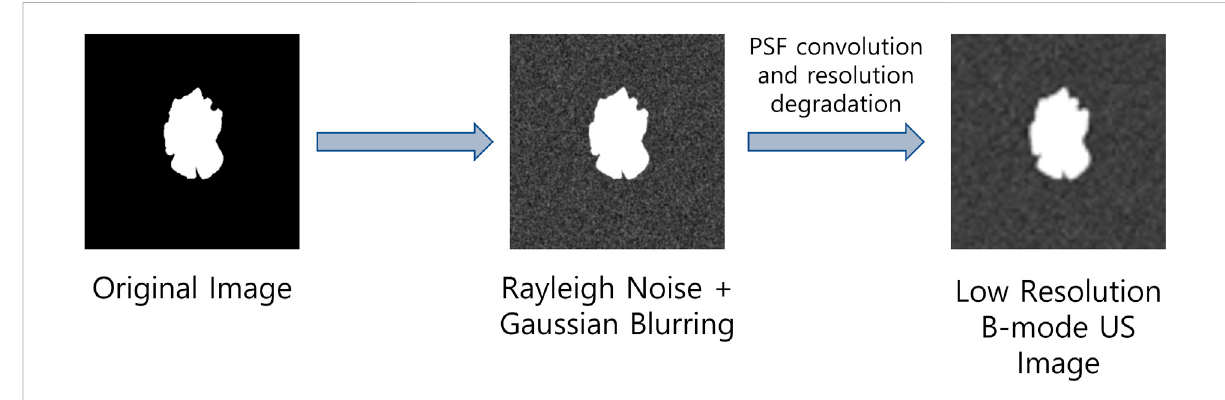
FIGURE 1 Ultrasound image formation physics informed dataset